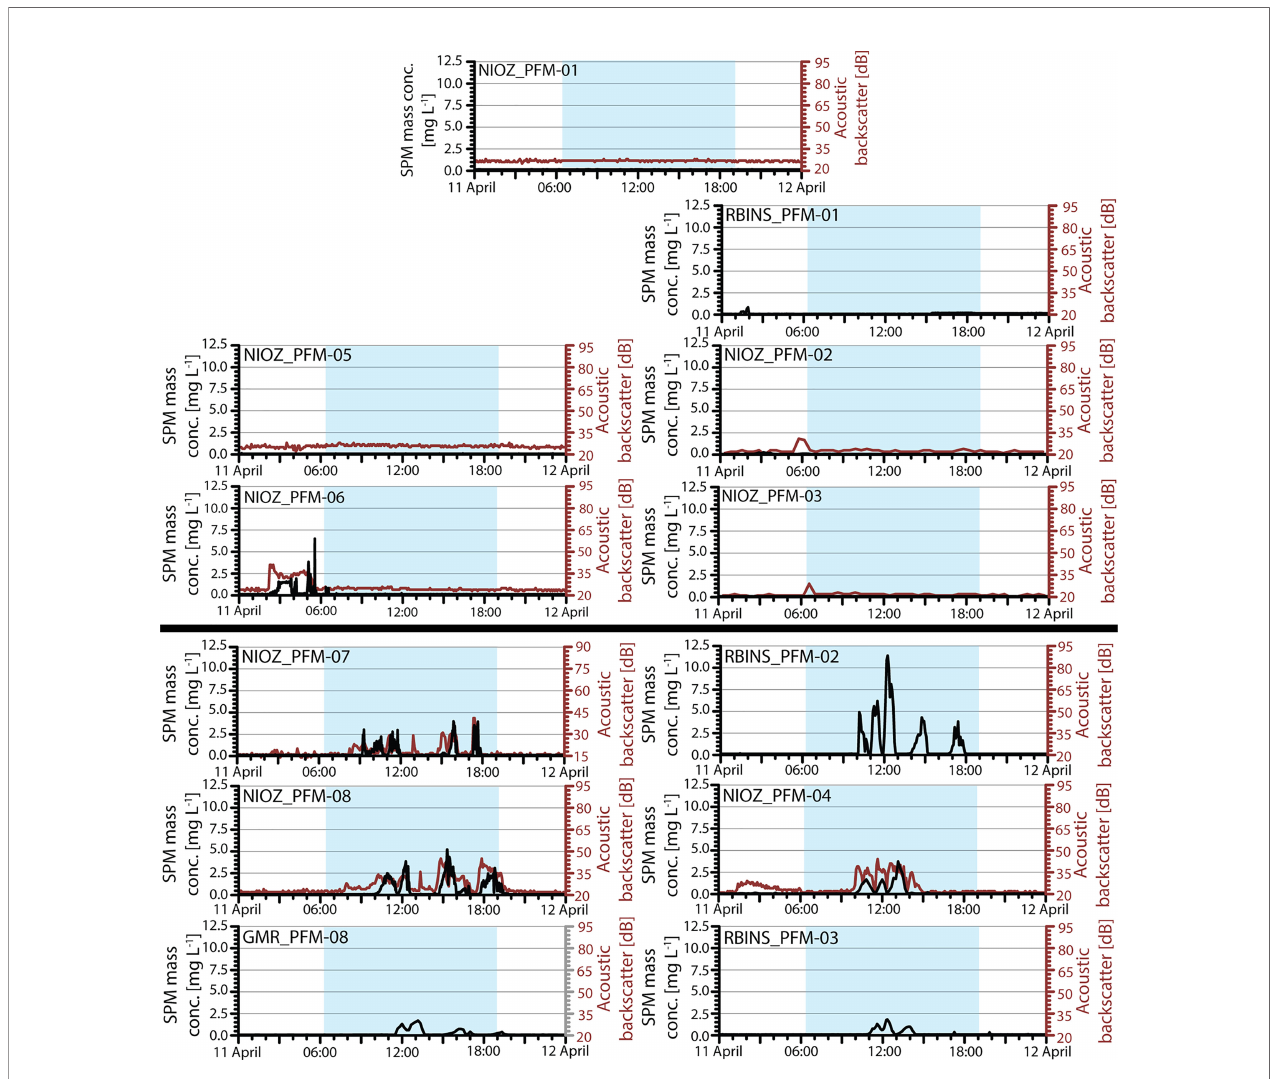
FIGURE 7 | Time series of SPM mass concentration as inferred from OBS measurements at 1 mab (black) and acoustic backscatter at 1.25 mab (red) recorded on the 11 th of April. The blue overlay indicates the time interval during which the dredging took place. The arrangement of the time series graphs corresponds with the geographical arrangement of the sensor platforms north and south of the dredge tracks (black line through the centre). It should be noted that in the representation of relative turbidity using a decibel scale, variation in the low concentration range appears disproportionally enhanced compared to variation in the high concentration range. The observed increase in recorded turbidity by both the optical and acoustic sensors of platform NIOZ_PFM-06 in the hours before the dredging took place, can be attributed to the sediment plume produced by lift-off of the elevator that was used for transferring sensor platforms from the ship to the sea fl oor. The elevator was located 80 m NE of the platform, while current at the moment of lift-off was in southwesterly